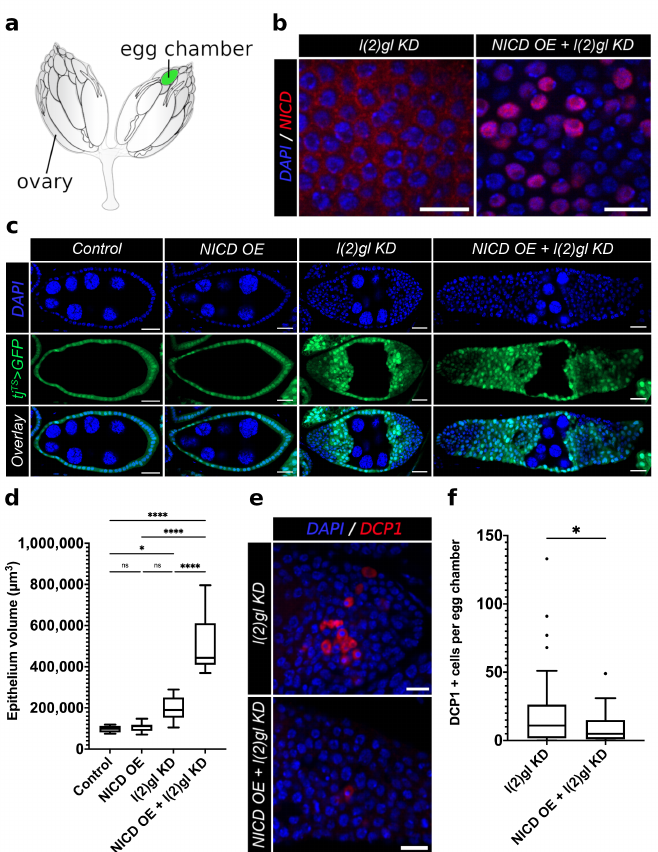
Figure 1. Nuclear accumulation of ectopic NICD promotes tumor growth and tumor cell survival in follicle cells. ( a ) An illustration of adult Drosophila ovaries connected by the oviduct. The position of a post-mitotic, mid-staged egg chamber is marked in green. ( b ) Confocal images comparing NICD antibody staining (red) patterns between l(2)gl KD and NICD OE + l(2)gl KD tumor cells. Both images are of post-mitotic, stage-7 egg chambers following three days of Gal4 activation in 29 ◦ C. NICD accumulates in high levels in NICD OE + l(2)gl KD cell nuclei compared to l(2)gl KD. ( c ) Confocal images of stage-7 egg chambers from each genetic background after 3 days of Gal4 activation in 29 ◦ C. The tissue-specific expression of tj TS > tj-Gal4, Gal80 TS , UAS GFP (GFP) marks all follicle cells in green, and DAPI marks all cell nuclei in blue. Scale bar = 20 µ m. ( d ) Box and whisker plot comparing epithelial volume between genotypes. N = 10 egg chambers from different individuals. Comparisons from the post hoc Tukey HSD are shown. (Ns) not significant, (*) p < 0.05, (****) p < 0.0001. ( e ) Confocal images comparing apoptosis marker, DCP1 (red), between l(2)gl KD and NICD OE + l(2)gl KD genotypes. Scale bar = 20 µ m. ( f ) Box and whisker plot of total number of DCP1-positive apoptotic cells per egg chamber. N = 50 egg chambers from 14 individuals. Significance value from t -test is shown (* = p <